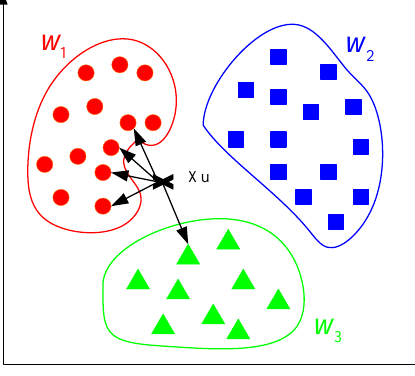
Figure 1. K-NN proximity algorithm map.